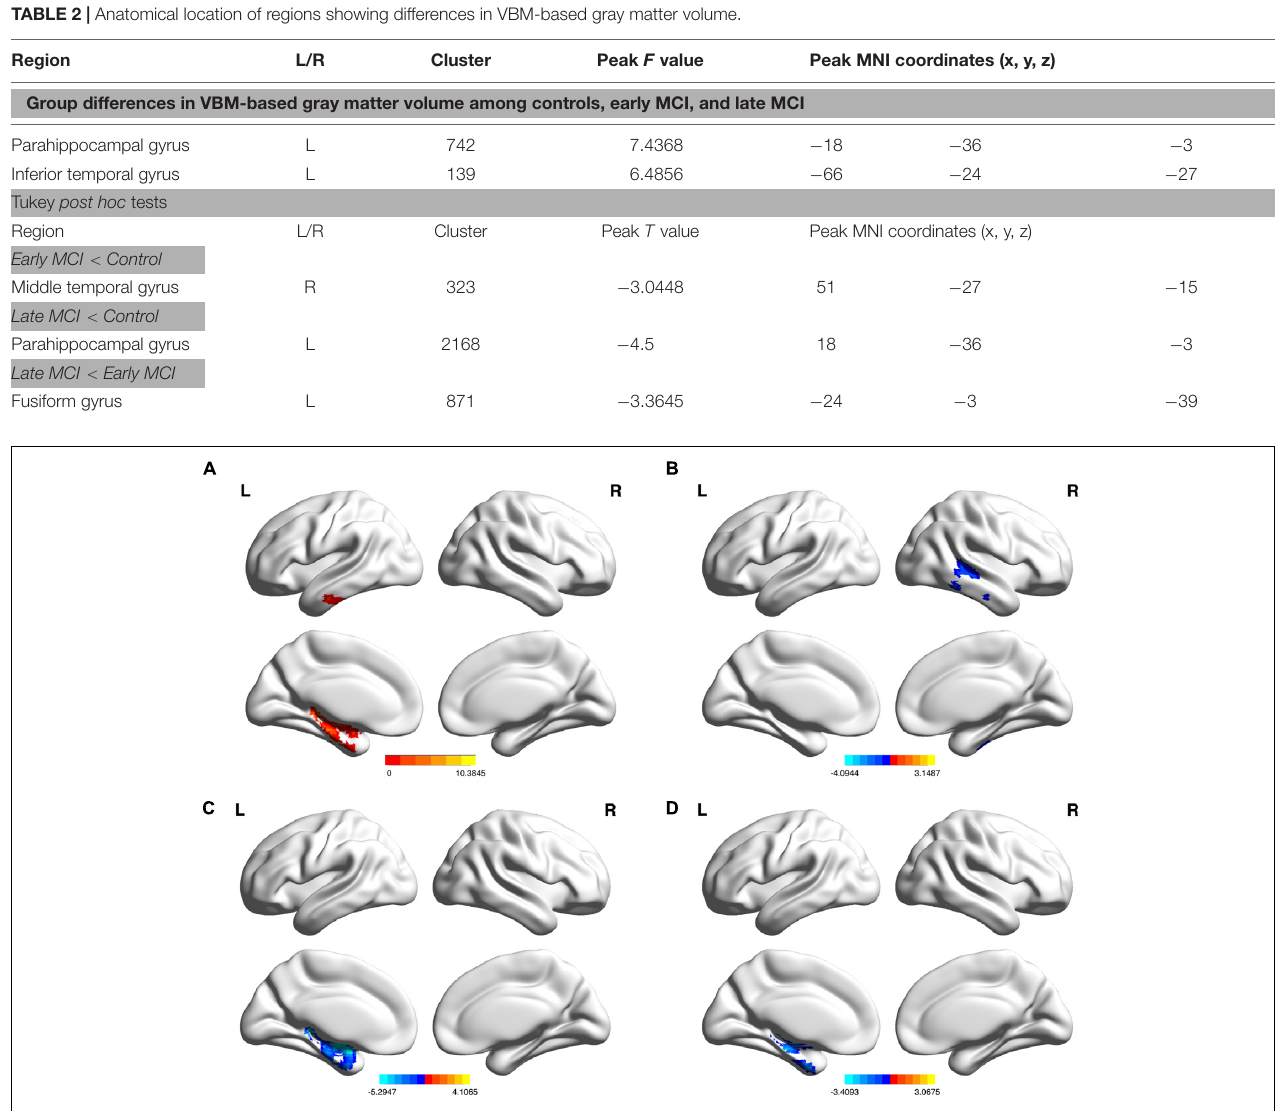
FIGURE 1 | (A) Regions of gray matter where normalized volume shows significant differences among the control subjects, early MCI patients, and late MCI patients (Monte Carlo simulation corrected p < 0.01). (B) Regions of gray matter where normalized volume shows significant reductions in the early MCI group in comparison to the control group. (C) In the late MCI group in comparison to the control group. (D) In the late MCI group in comparison to the early MCI group (Tukey post hoc tests, Monte Carlo simulation corrected p <